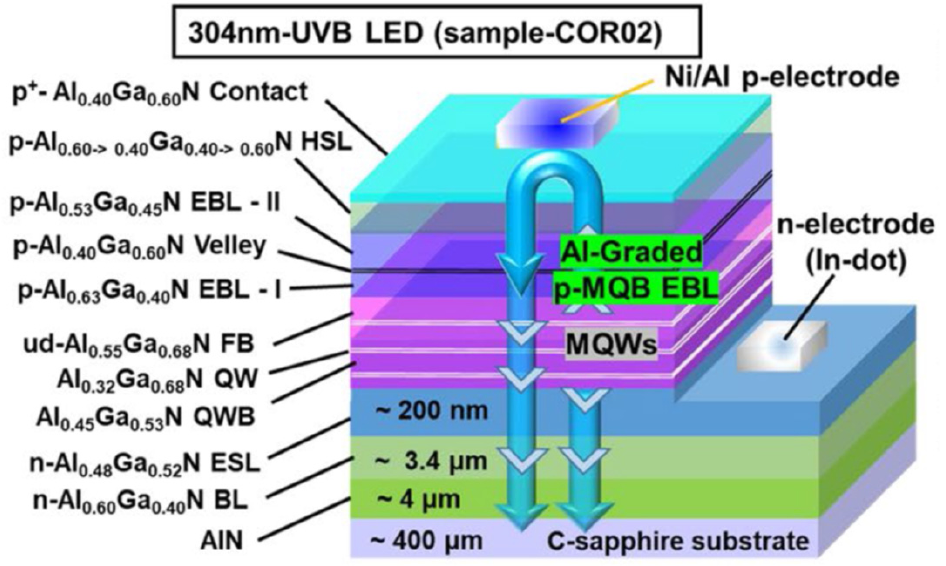
Figure 7. Schematic diagram of 304 nm-band AlGaN-based UVB-LED. [24] Copyright 2022, Springer Nature Publishing. Table 1. A comparison of AlGaN-based UV-LED manufacturing techniques.